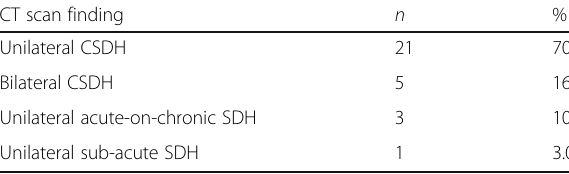
Table 2 Radiological findings on CT scans CT scan finding